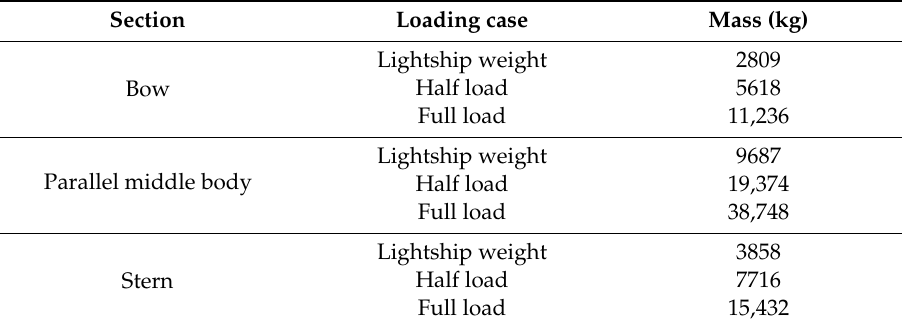
Table 6. Loading set of each section.